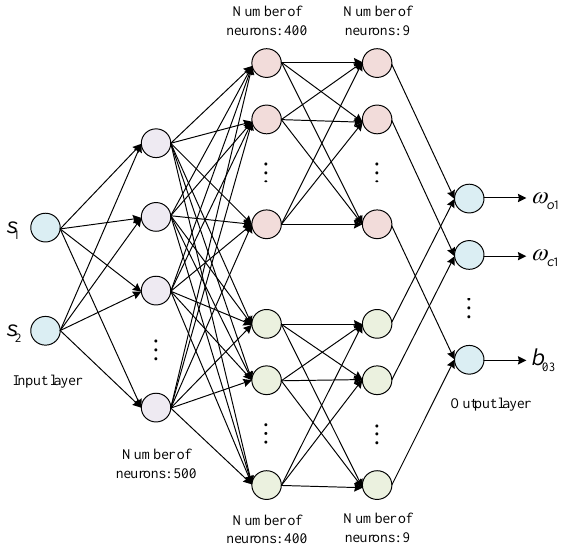
Figure 5. Structure diagram of actor